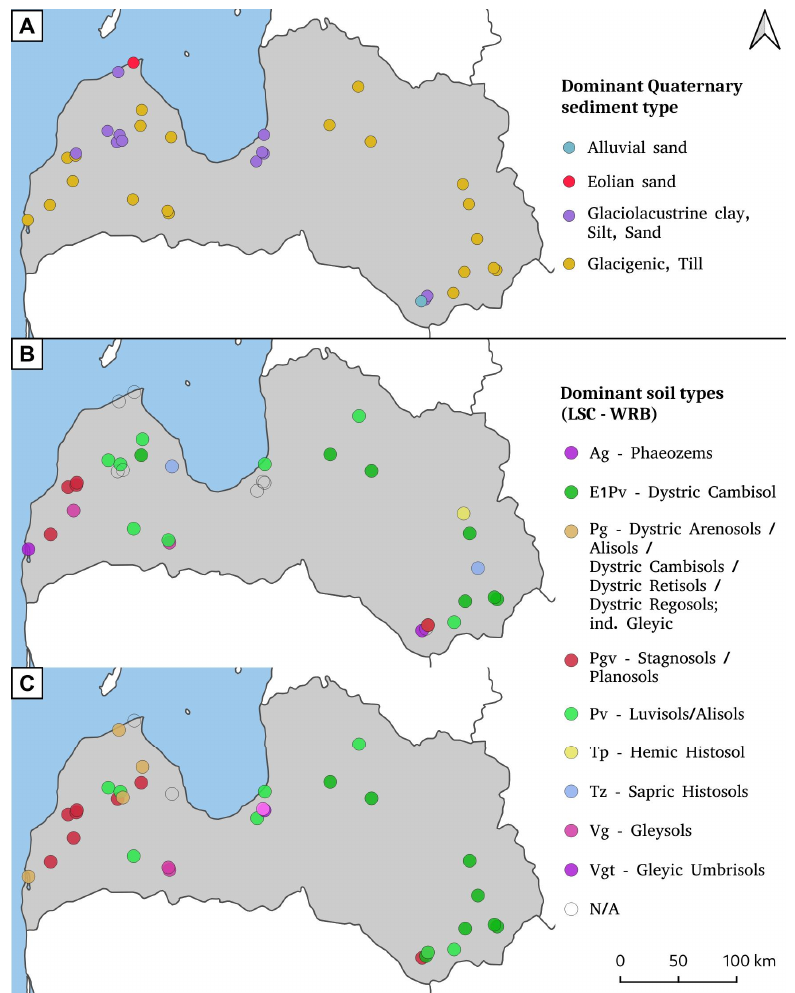
Figure 3. Dominant Quaternary sediment type within 4 km around the waterbodies ( A ) and dominant soil (LSC-WRB) type within 1 km ( B ) and 4 km ( C ). LSC—Latvian Soil Classification and WRB—World Reference Base for Soil Resources.